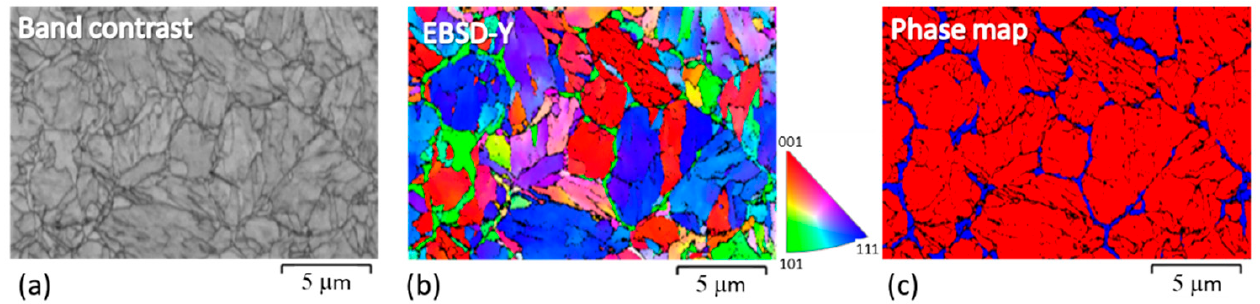
Figure 6. Electron back scattered diffraction (EBSD) analysis of the metallographic section through the powder: ( a ) band contrast; ( b ) Inverse pole figure in the direction Y (IPF–Y figure); ( c ) phase map with blue—retained austenite at cell boundaries, red—martensitic matrix.